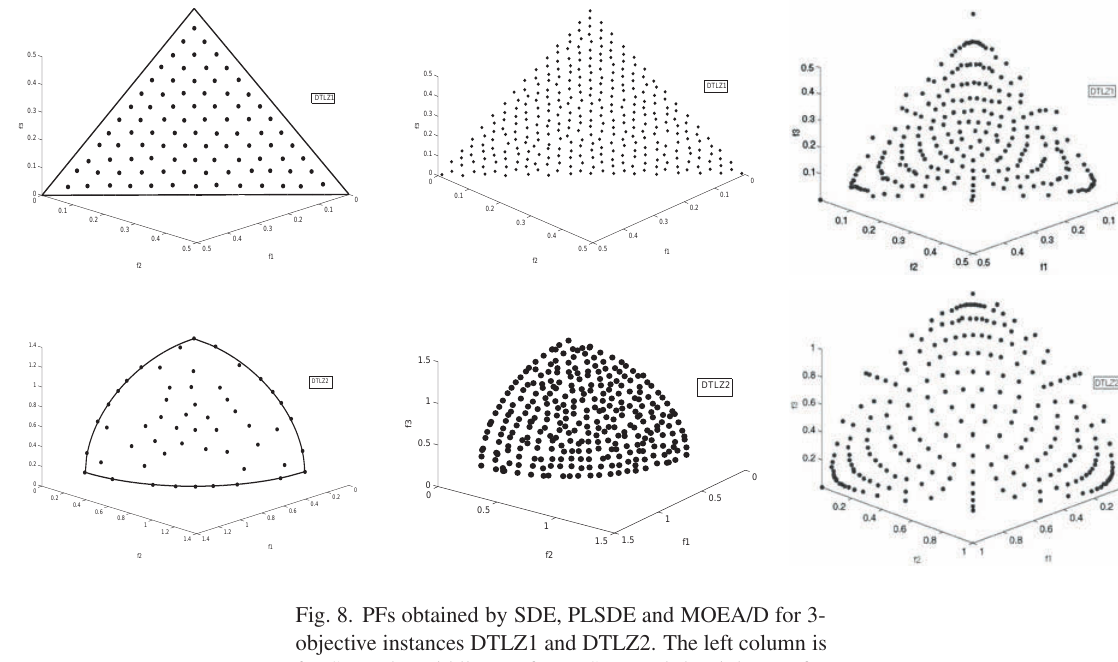
Fig. 8. PFs obtained by SDE, PLSDE and MOEA/D for 3- objective instances DTLZ1 and DTLZ2. The left column is for SDE, the middle one for PLSDE and the right one for